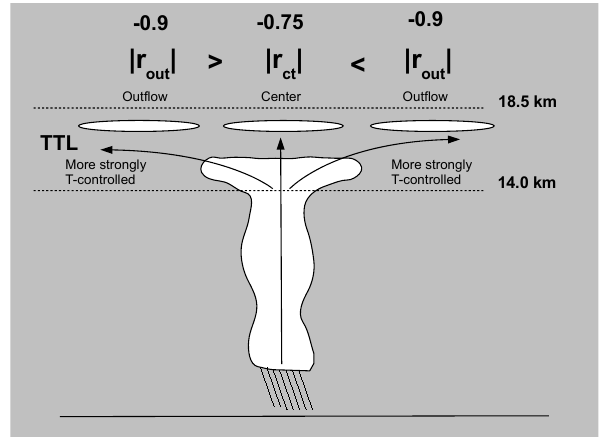
Fig. 7. Drawing of cumulus convection and cirrus formation (nar- row clouds on top) inside the TTL. The anticorrelation ( r ) of water vapor and cirrus is higher in the outflow regions than it is in the center of the convective region ( | r out | > | r ct | ). Small changes of temperatures have a bigger effect on the state of water in the out- flow regions therefore ice transforms to vapor and back hence the anticorrelation is